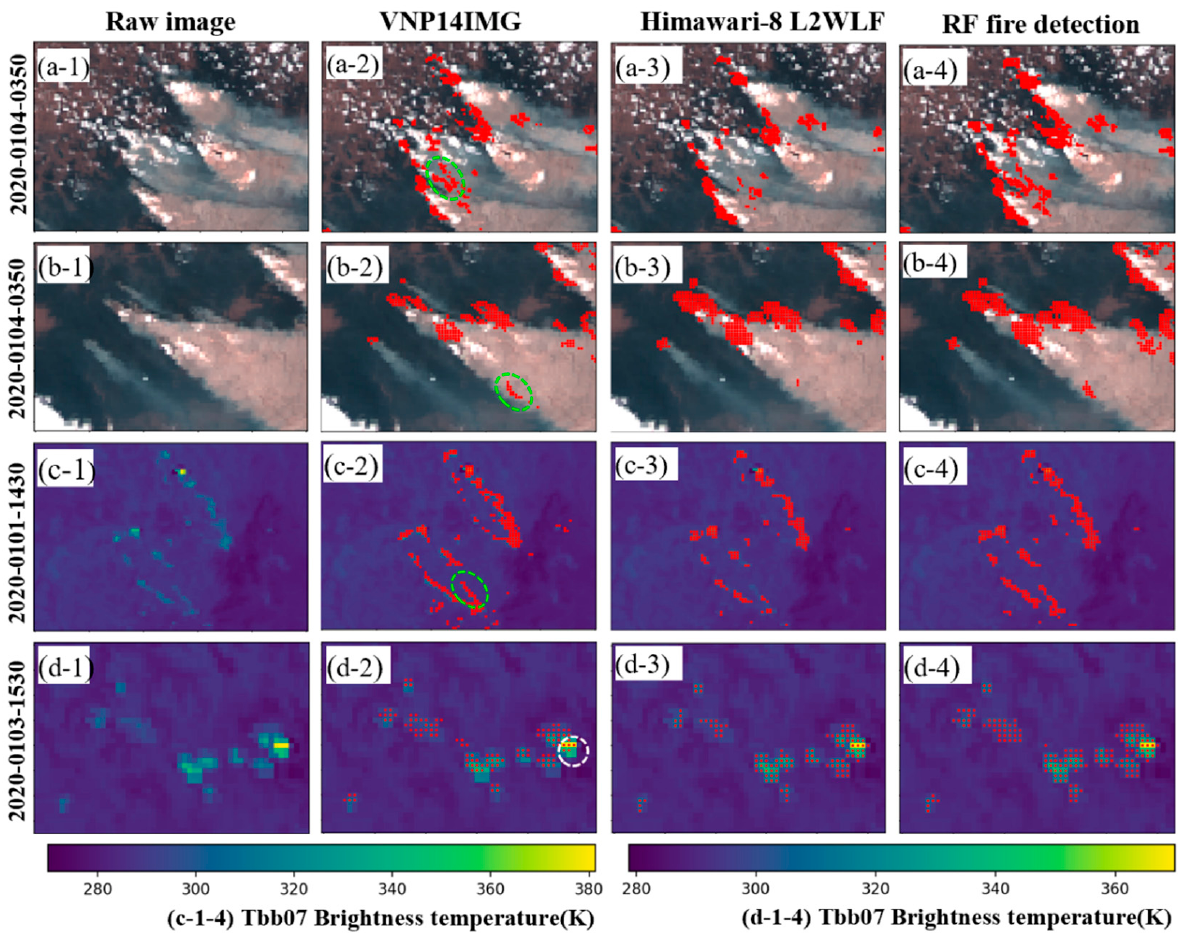
Figure 3. Fire detection results (column 1 is the original Himawari-8 image, where ( a-1 , b-1 ) are true color-composite images of bands 1, 2, and 3; ( c-1 , d-1 ) are single-band images of band 7; and columns 2, 3, and 4 are the results of fire pixels obtained from the different products and models overlayed onto the original image, where ( a-2 , b-2 , c-2 , d-2 ) are the fire detection results of the VNP14IMG product in four sample areas respectively; ( a-3 , b-3 , c-3 , d-3 ) are the fire detection results of the Himawari-8 L2WLF product in four sample areas respectively; ( a-4 , b-4 , c-4 , d-4 ) are the fire detection results of the RF models in four sample areas respectively ).